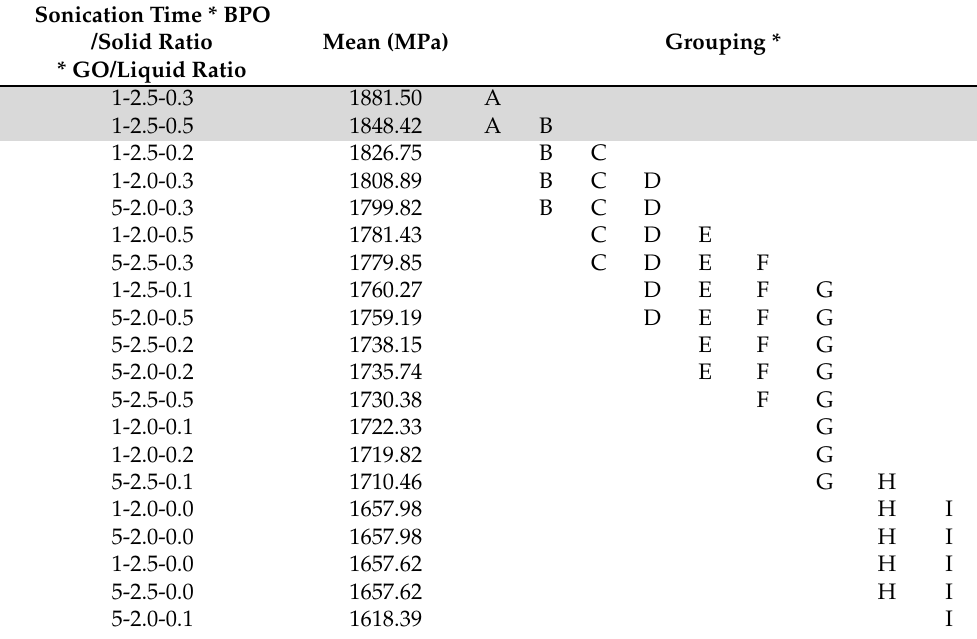
Table 5. Grouping information for compressive modulus using Tukey’s test and 95%